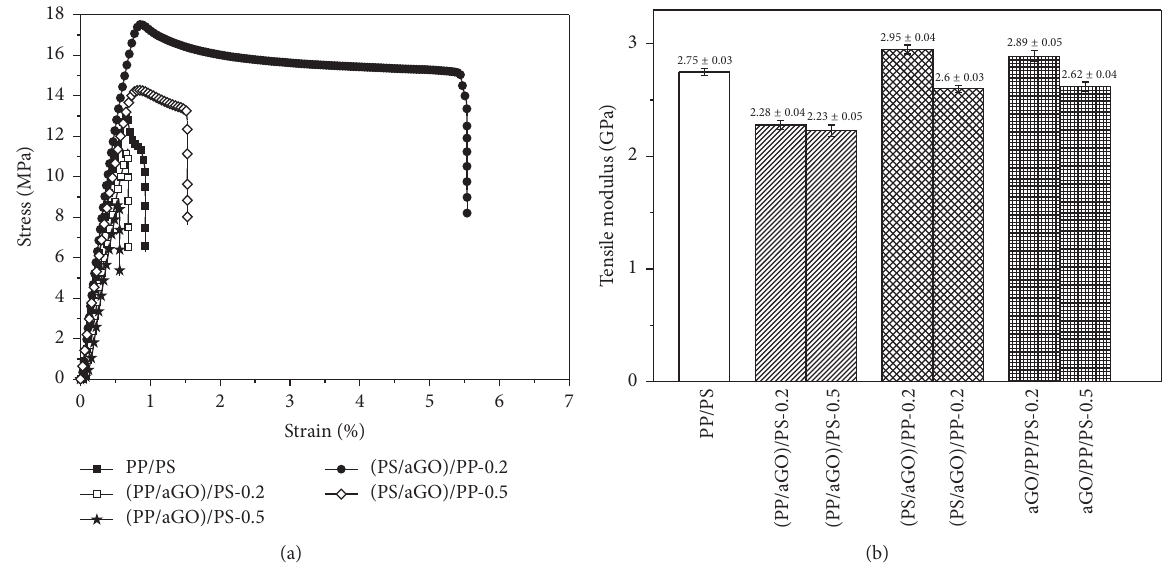
Figure 8: Stress-strain curves (a) and tensile modules (b) of (PS/aGO)/PP and (PP/aGO)/PS systems.